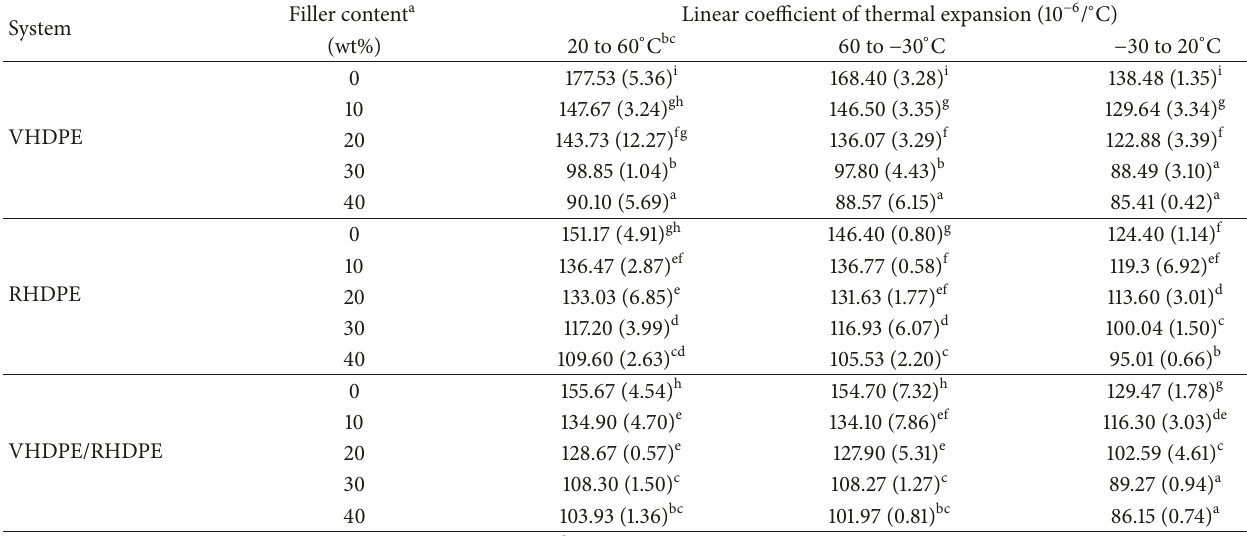
Table 1: Effect of PB dust content on thermal expansion coefficient of PB dust filled